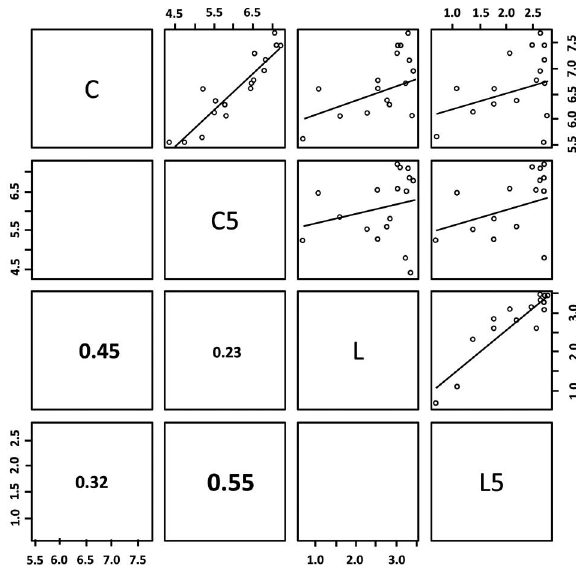
Fig. 6. – Scatterplot matrix for the response variable catch consid- ered by year (C), May (C ) and two selected explanatory variables 5 for wind speed data: ≤ 15 knots (L), by month (L5). The upper di- agonal panels show the pair-wise scatterplots including a straight line. The lower diagonal boxes contain the absolute correlations coefficients of Pearson’s test (r). The pairplot indicates a clear linear relationship between C5 × L5 (r=0.55) and a lesser one between C × L (r=0.45).